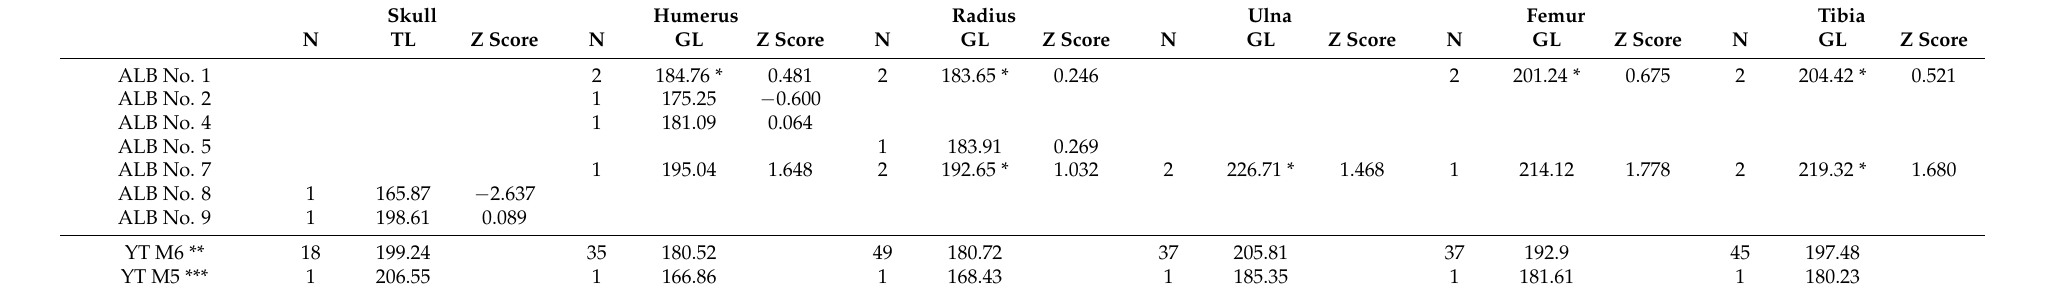
Table 5. Osteometric measurements of the Alaybeyi dogs and their comparison with the Yoncatepe dogs.